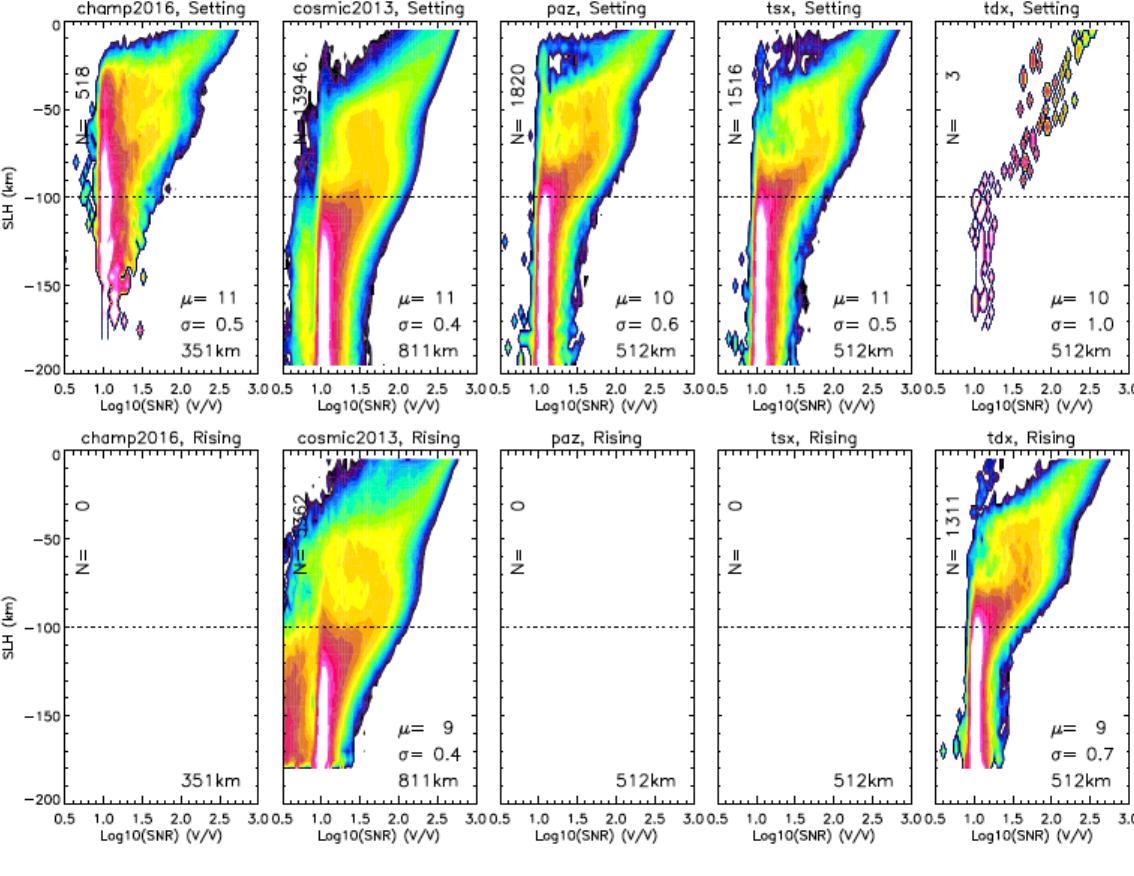
Figure A2. SNR statistics for the CHAMP, COSMIC-1, PAZ, TSX, and TDX receivers. The mean SNR values at H SL = − 150 km are used to determine m (V/V). The 2007 CHAMP, 2009 COSMIC-1, 2020 PAZ, 2019 TSX, and 2019 TDX data are used in the analysis.